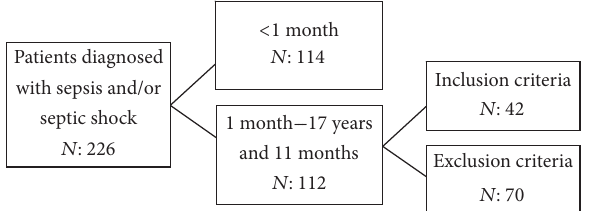
Figure 1: Flow chart of children included in the study.